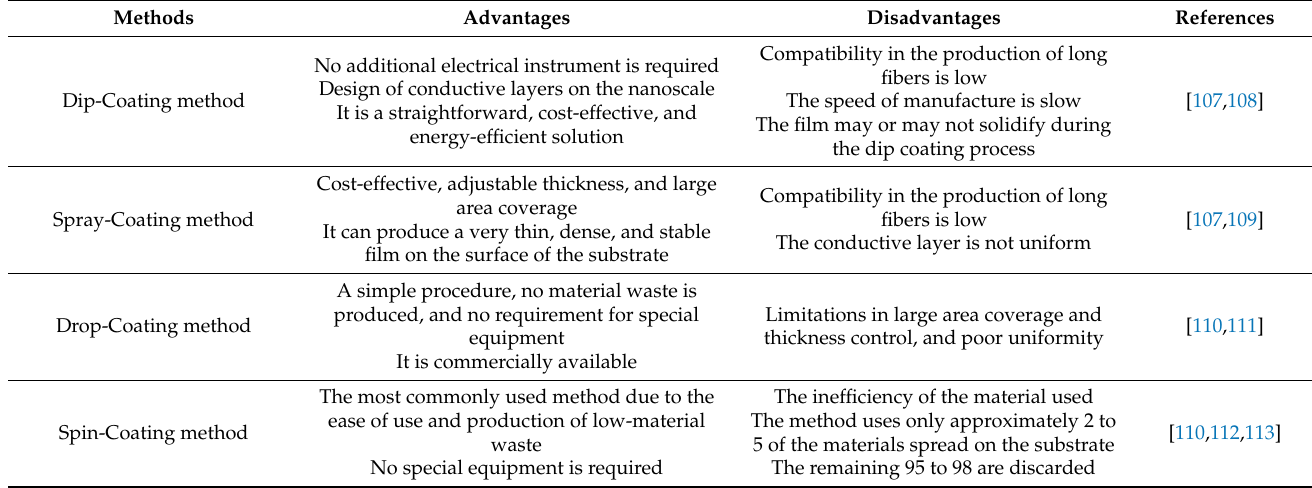
Table 1. Comparison of assembly methods for manufacturing fibers: dip-coating, spray-coating, drop-coating, and spin-coating